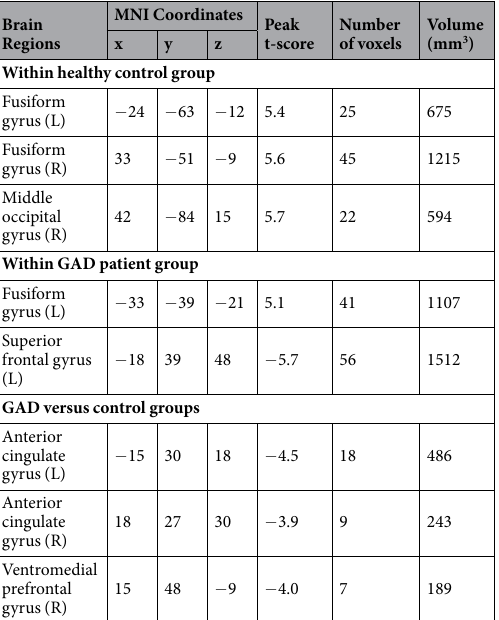
Table 3. Regions showing significant psychophysiological interaction (PPI) with right inferior frontal gyrus in the contrast of negative versus neutral stimulus processing. Note: GAD = generalized anxiety disorder, L = left, R = right. For the group-wise analysis, the threshold was set at p < 0.05, AlphaSim corrected (i.e., p-voxel < 0.0005 with minimum cluster size = 22 voxels). For the Between-group analysis, we considered p-voxel < 0.001(uncorrected) to be statistically significant.